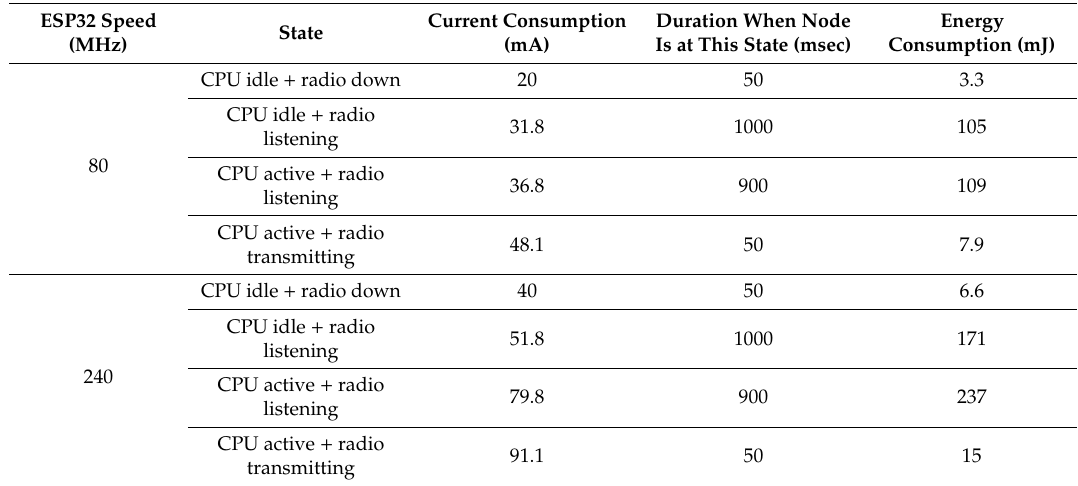
Table 3. Simulated current consumption of the sensor node at di ff erent states.